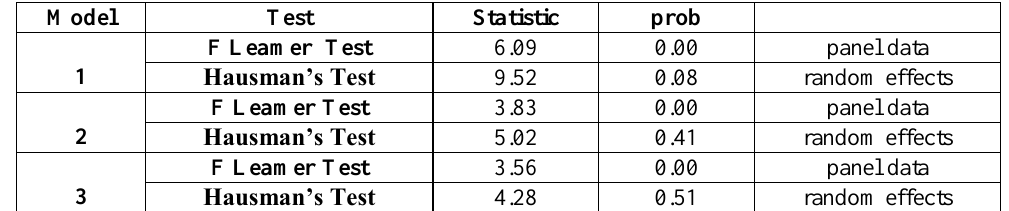
Table 5. Research model estimation